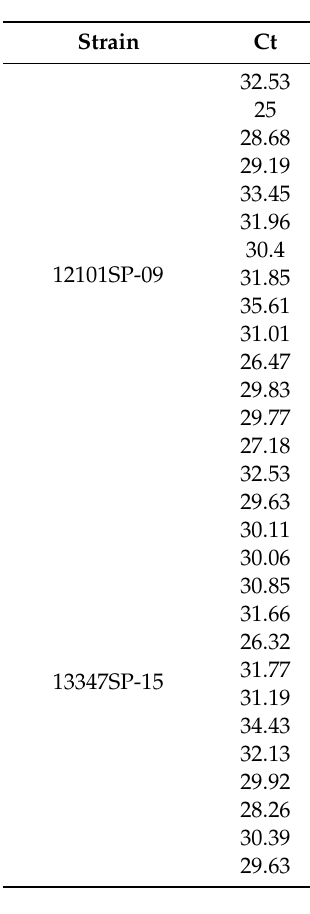
Table 4. Average Ct values of RT-qPCR from tracheal swabs of chicks challenged with three di ff erent isolates from di ff erent